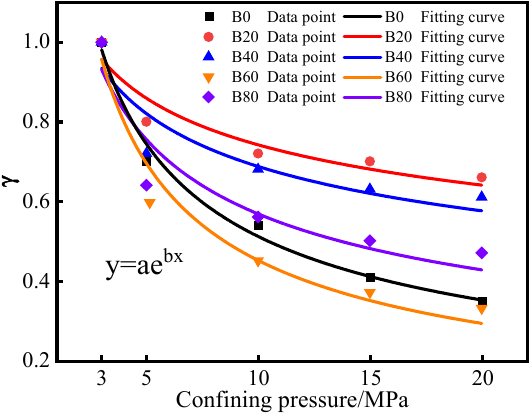
Figure 6. Confining pressure-sensitivity fitting curve.